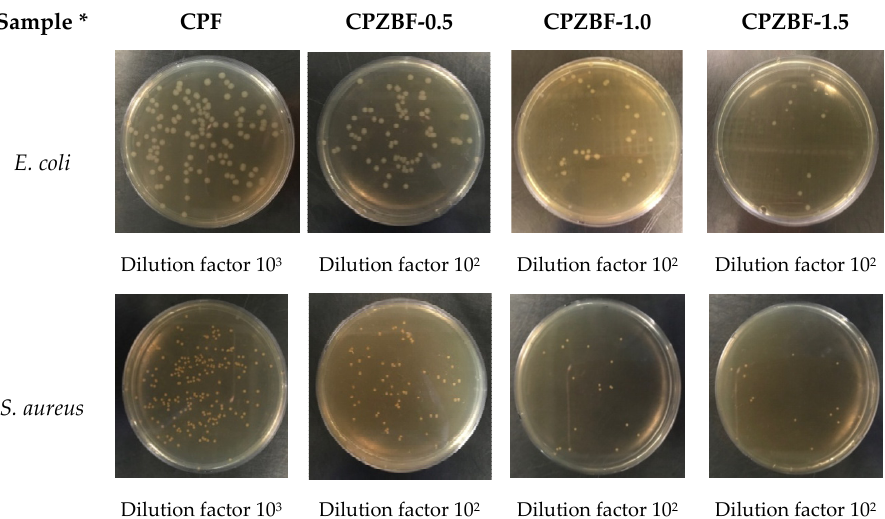
Figure 5. Colony forming units (CFU) of E. coli and S. aureus after exposure to crosslinked pectin film (CPF) and crosslinked pectin/ZnO bionanocomposite films (CPZBF). * Concentrations represent % ZnO ( w/w ).